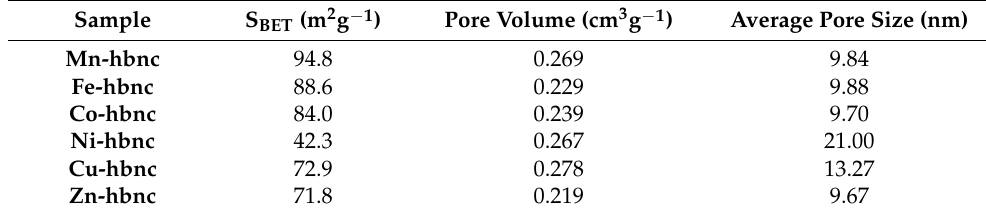
Table 5. Textural parameters of the samples.